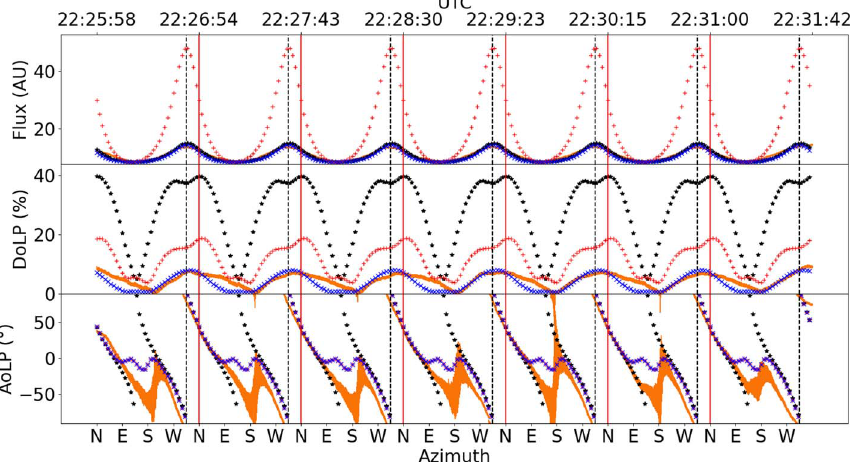
Fig. 5. In orange, the observations of the polarisation fl ux (top), DoLP (middle), and AoLP (bottom) at 620 ± 5 nm over 7 almucantars on February 27, 2020. The thickness of the line indicates the uncertainties). A sliding average of 10 s is applied. Black stars ( H ): model without aerosols (no Mie scattering) nor isotropic background ( c = 0). Red plus (+): idem but model with aerosols. Blue ( (cid:2) ): same as red with an isotropic background set to fi t the fl ux. The vertical dashed lines show the Skibotn